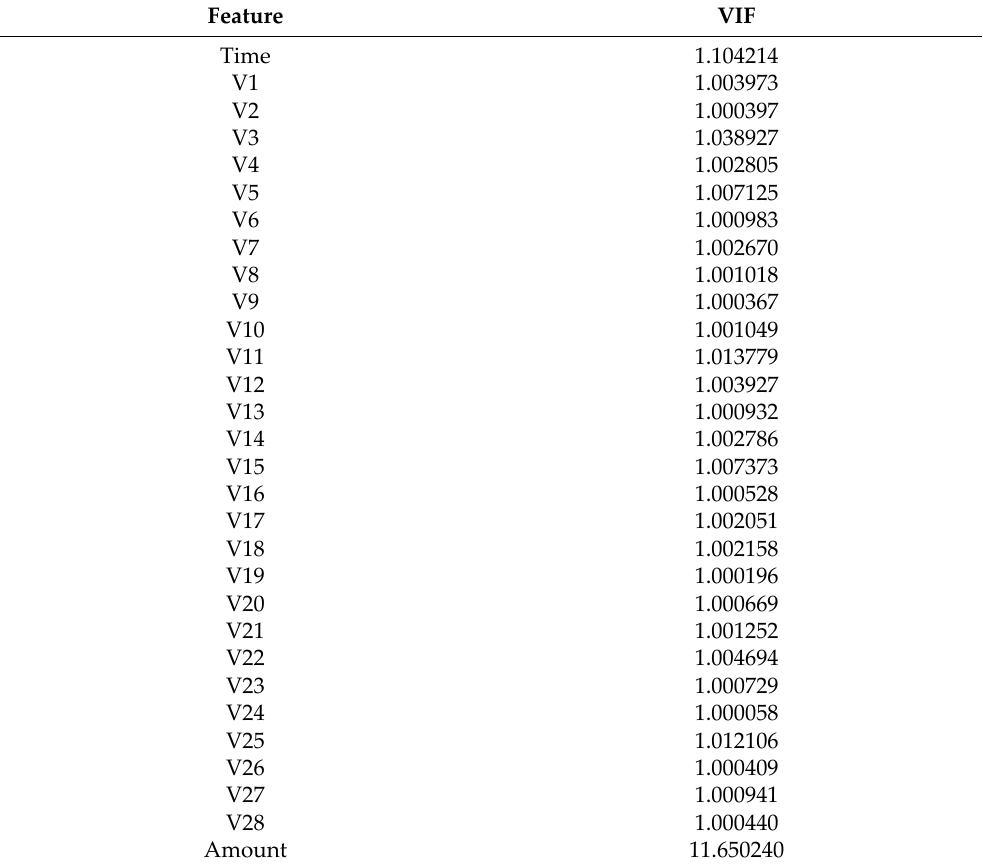
Table 3. Variance inflation factor